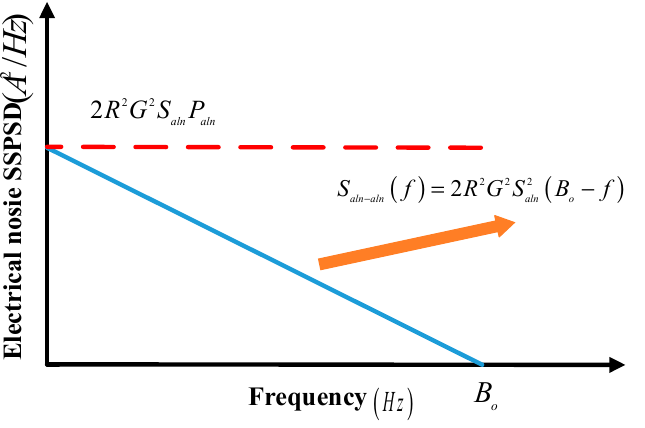
Figure 11. SSPSD of AL–AL beat noise.